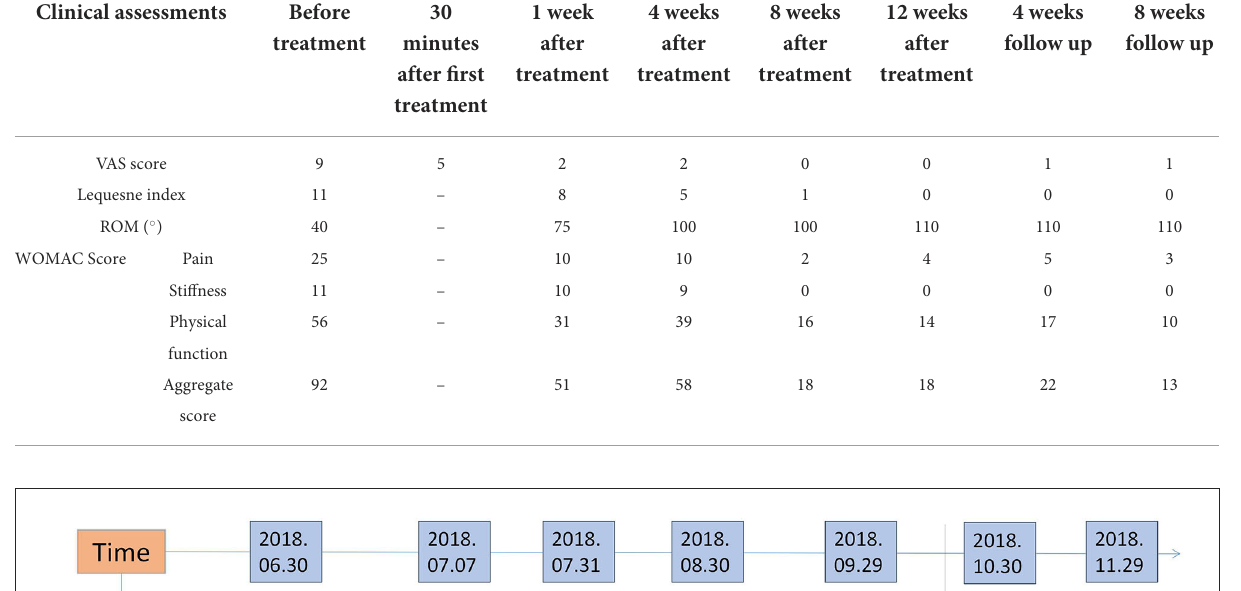
TABLE 1 Clinical assessments for pain and knee joint function at each time points. Clinical assessments